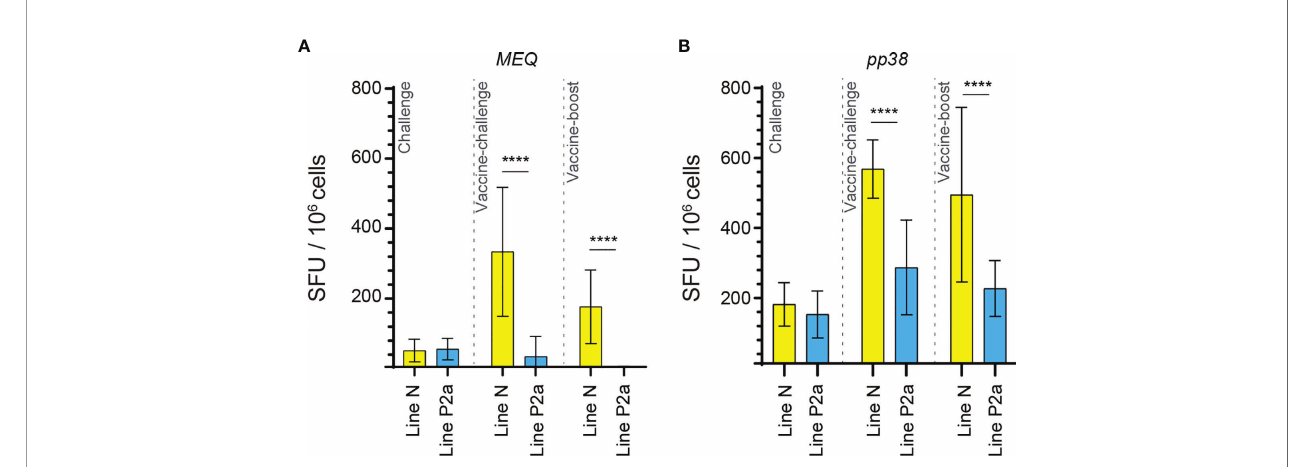
FIGURE 3 | Higher frequencies of MEQ and pp38 -speci fi c T cell responses in line N chickens compared to line P2a chickens from vaccine-challenge and vaccine- boost groups at week 2 post inoculation. The frequencies of (A) MEQ (B) pp38 -speci fi c IFN-gamma producing T cell responses in line N (yellow bars) and line P2a (blue bars) chickens within the challenge, vaccine-challenge, and vaccine-boost groups are shown at 2 weeks post last inoculation using standard ex vivo ELISPOT assay. The results are presented as SFU per 10 6 cells and shown as mean ± SD. Non-parametric Wilcoxon tests (Mann – Whitney) was used to assess normal distribution and test signi fi cance. **** ( P ≤ 0.001) indicates as statistically signi fi cant.